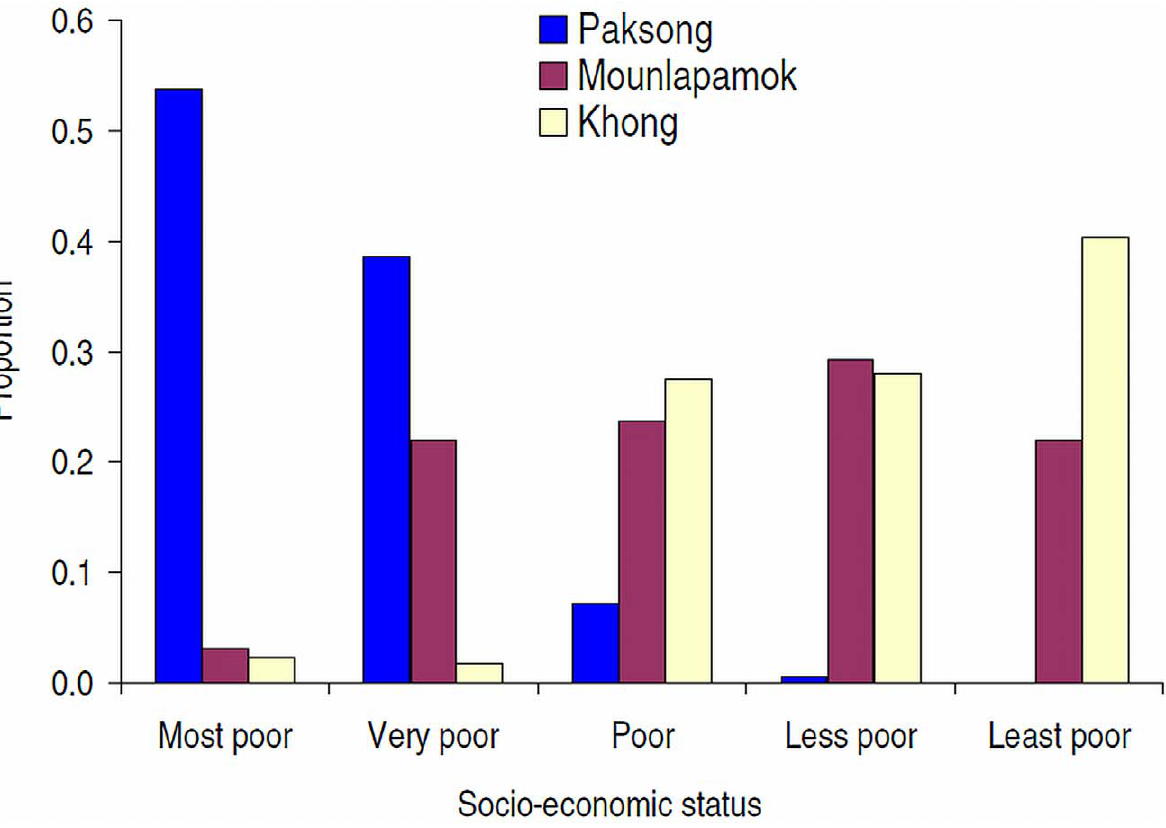
Figure 3. Socioeconomic status among individuals from Champasack province, southern Lao PDR, stratified by study setting (n=669).